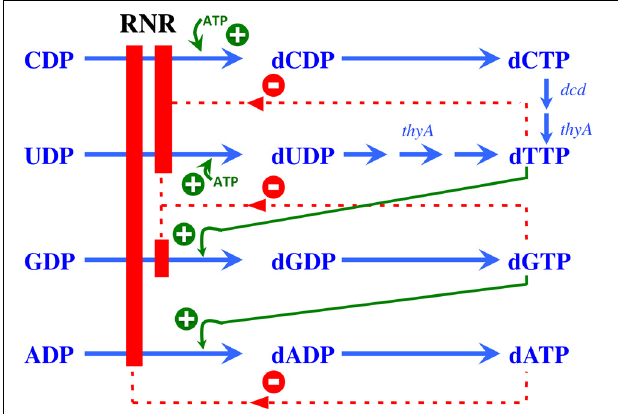
FIGURE 2 | Allosteric regulation of RNR. Model showing the allosteric regulation of class Ia RNRs. The binding of ATP at the substrate specificity site activates the enzyme, promoting the reduction of CDP and UDP to dCDP and dUDP, respectively. Once formed, dTTP promotes the reduction of GDP to dGDP, which in turn induces the reduction of ADP to dADP. A high dATP concentration inhibits the overall activity of this enzyme through binding to the allosteric activity site. Green plus symbols indicate stimulation of RNR reduction, and red minus symbols indicate inhibition.